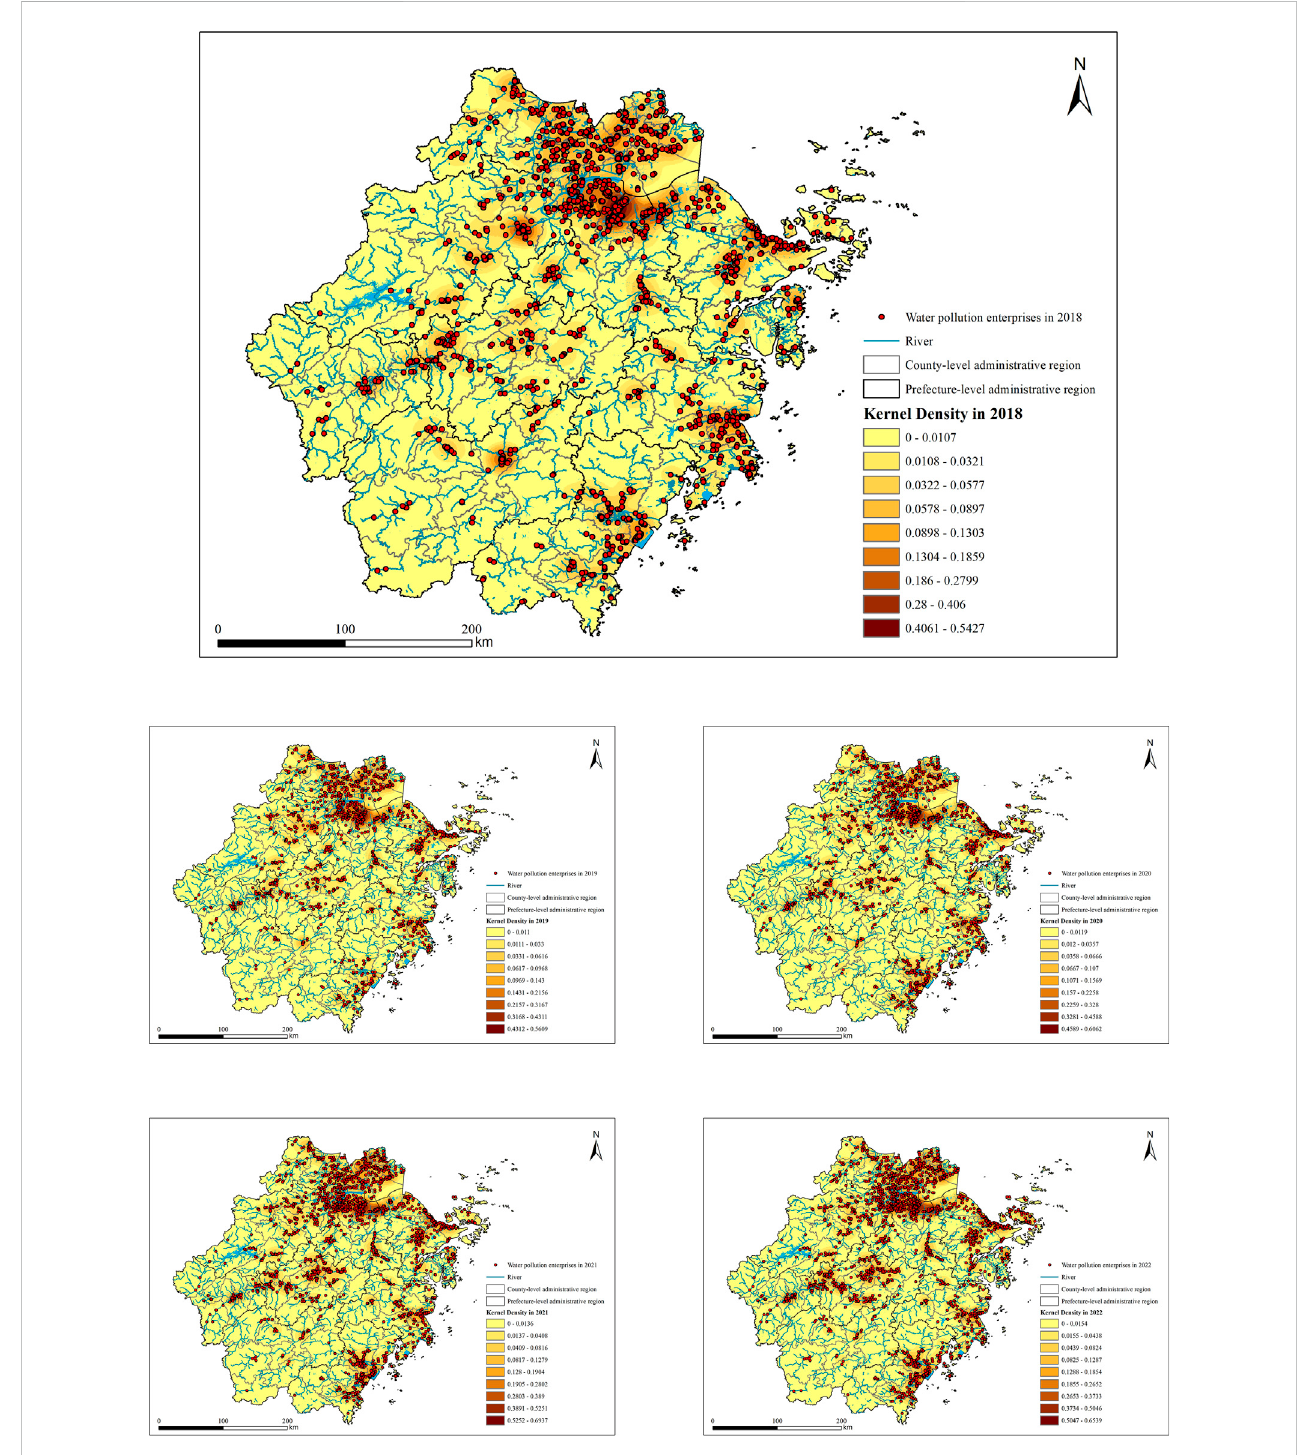
FIGURE 2 Estimation of the kernel density of water-polluting enterprises in Zhejiang province from 2018 to